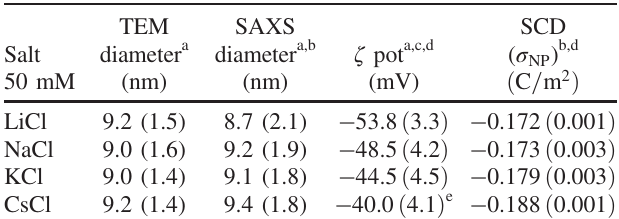
FIG. 4. p H-dependent surface charge density of colloidal silica in (a) 50-mM LiCl, (b) 50-mM NaCl, (c) 50-mM KCl, and (d) 50- mM CsCl. Markers: Experimental results from three repeat measurements. Solid lines: Fits from surface complexation mod- eling using the basic Stern model and 4 . 75 OH sites = nm. The point of zero charge is set at p H 3.0 in all